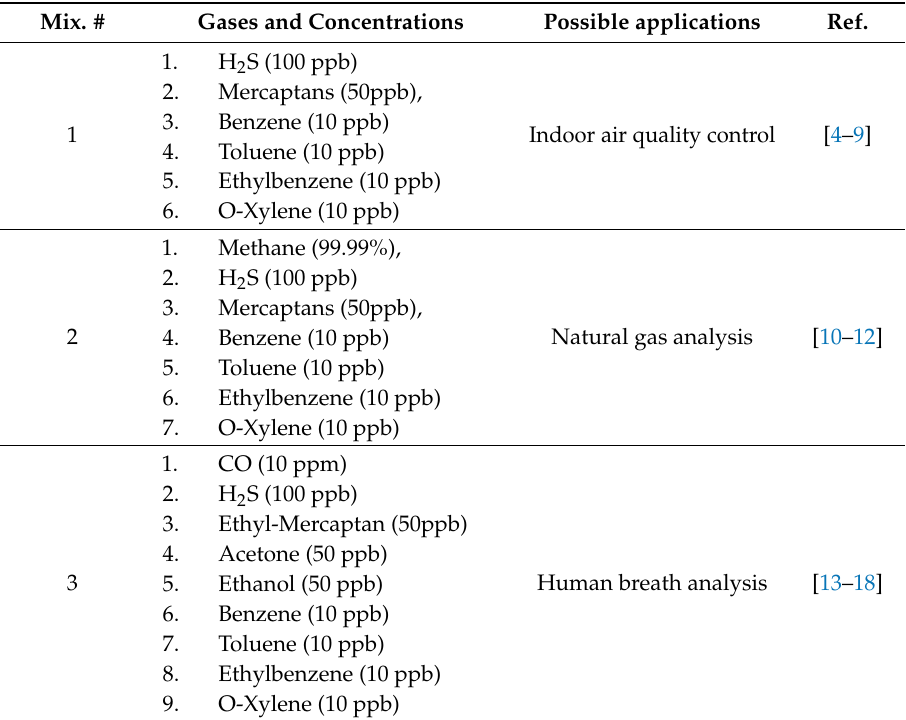
Table 2. Gas mixtures and concentrations.